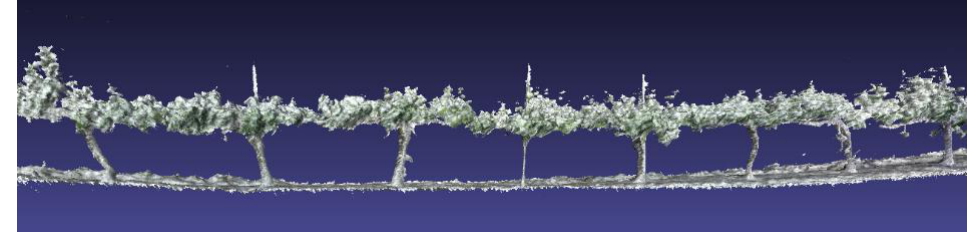
Figure 12. 3D reconstruction of a row of vines.